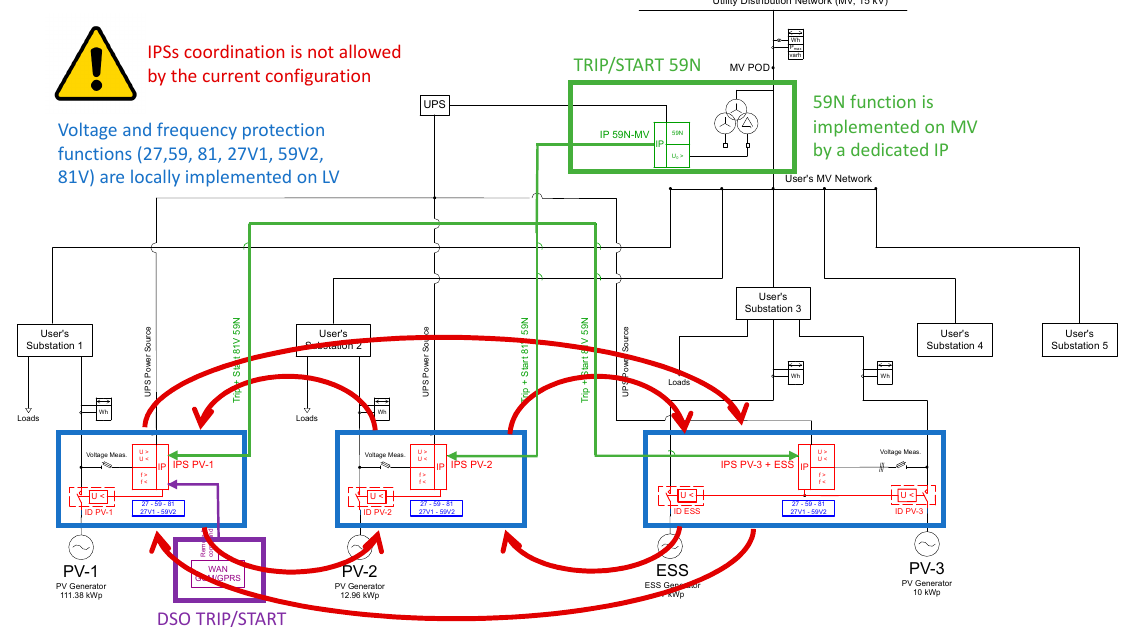
Figure 3. Schematic representation of the anti-islanding protection functions currently implemented in the Engineering campus of the University of Brescia.